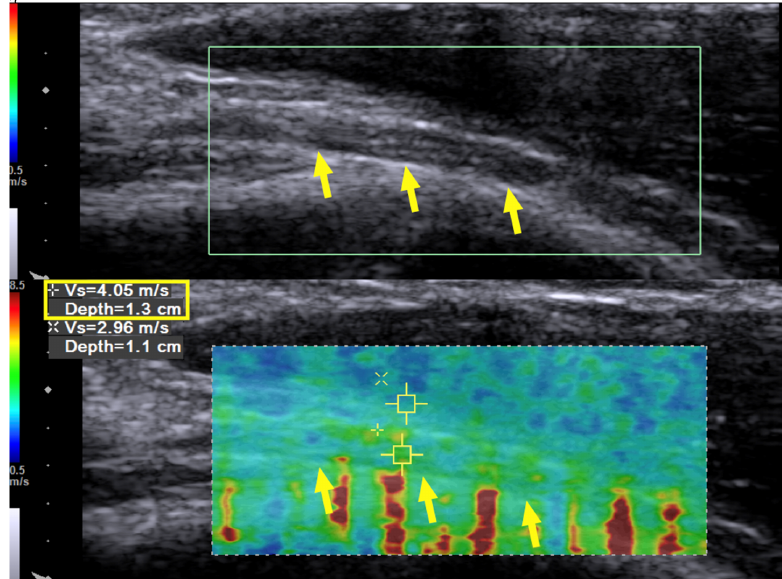
2 Figure 2. Case 1: Ultrasound imaging with shear wave elastography. Long-axis ultrasound imaging of the radial nerve on the contralateral arm with shear wave elastography. Shear wave velocity measurement of the normal radial nerve was 4.05 m / s (longitudinal view at the beginning of the spiral groove). Yellow arrow and box: radial nerve in longitudinal